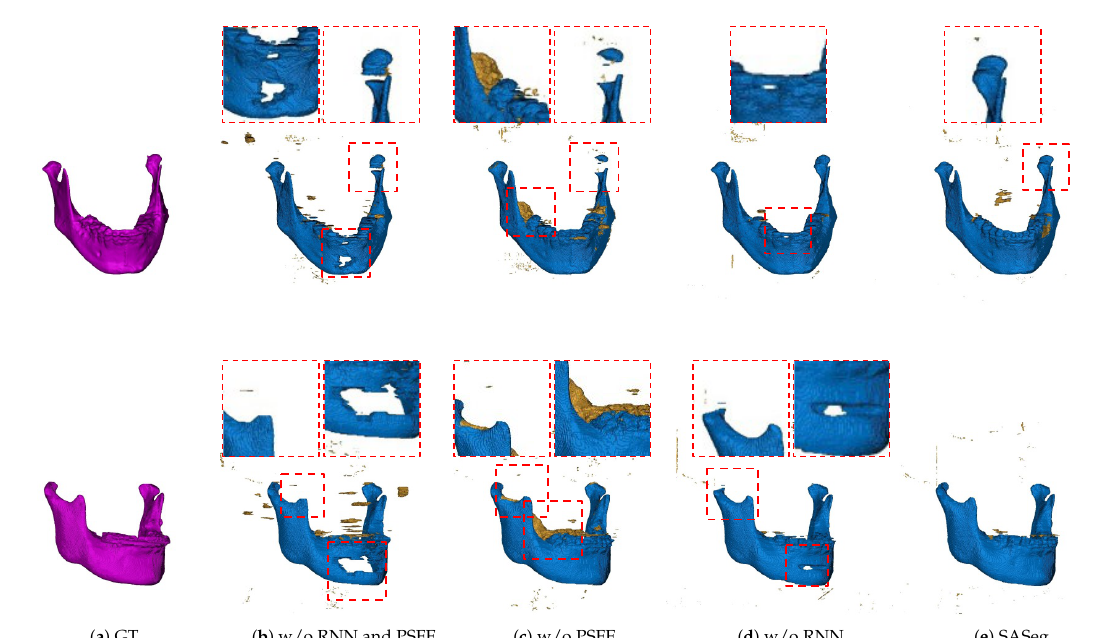
Figure 7. Results with different ablations of our method. The ground truth is shown in column ( a ). Columns ( b – e ) illustrate the segmentation results derived from the model without RNN and PSFE modules, without the PSFE module, and without the RNN module and the proposed SASeg, respectively. The red rectangle indicates the zoom-in views of bad predictions. (w/o RNN and PSFE: without RNN and PSFE modules, w/o PSFE: without the PSFE module, and w/o RNN: without the RNN